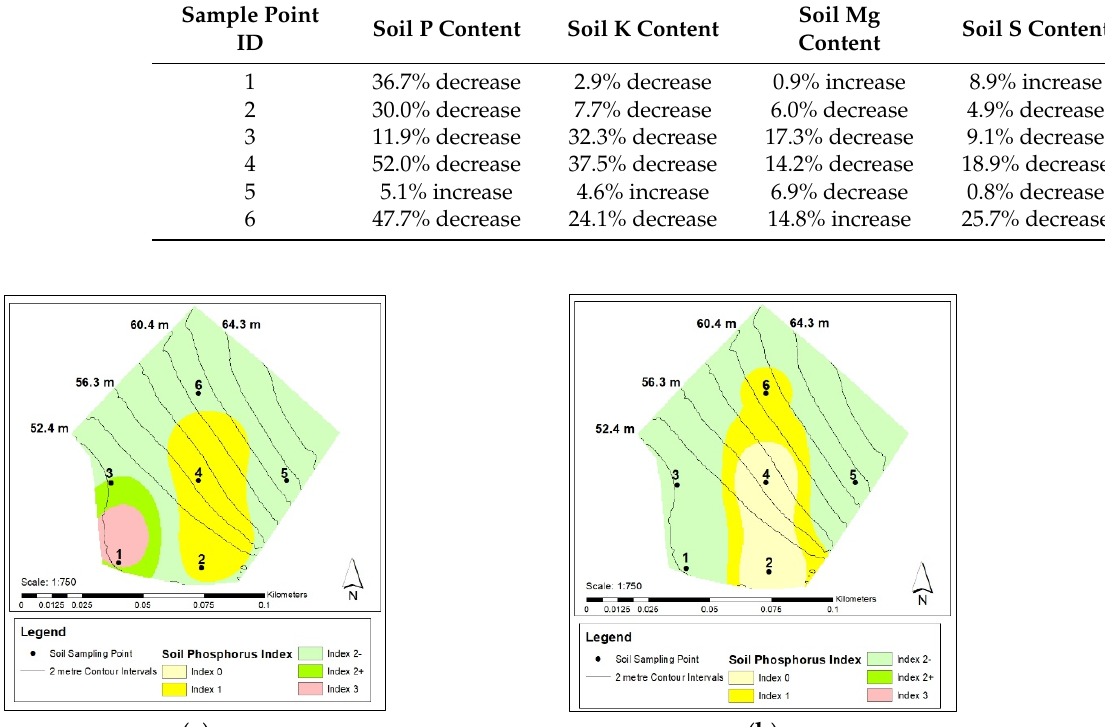
Figure 1. Interpolated phosphorus content with ( a ) soil P content in 2020 and ( b ) soil P content in 2021. in